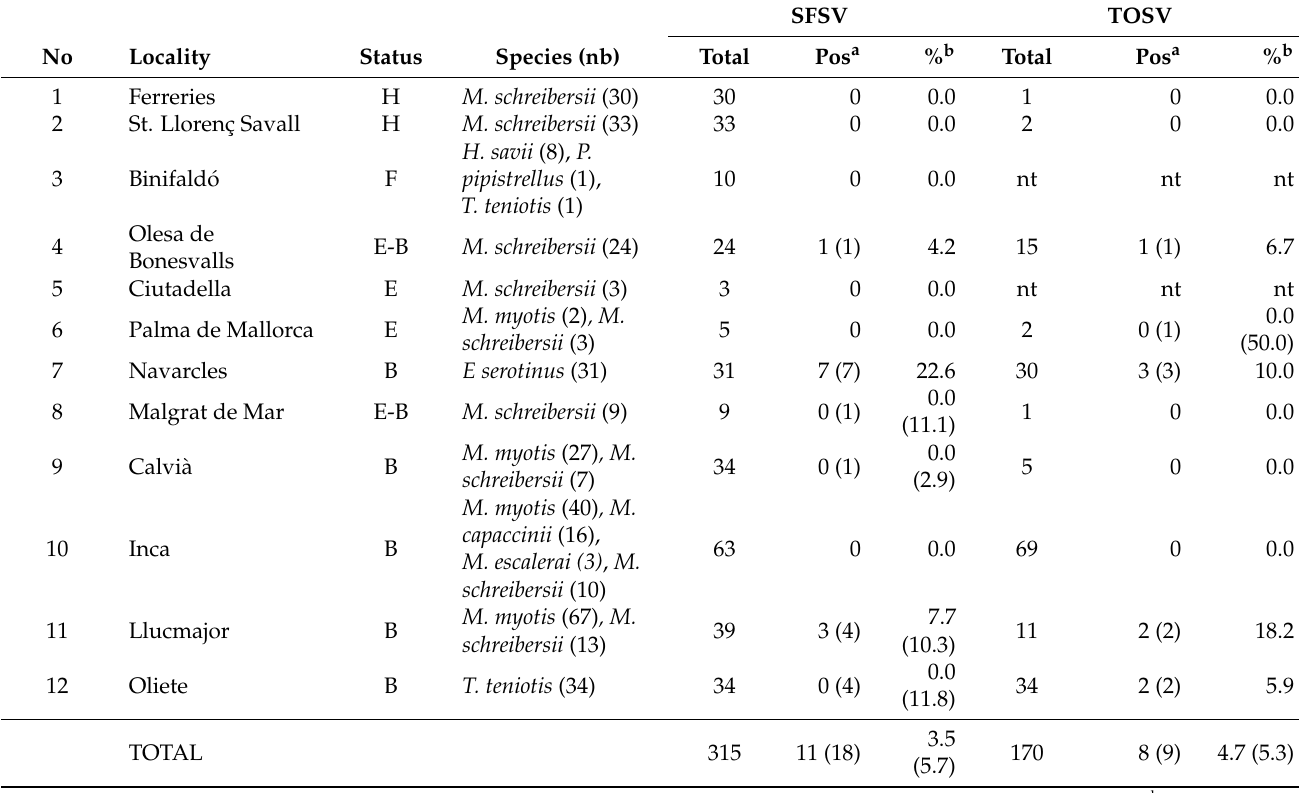
Table 2. Distribution of tested specimens per locality and presence of neutralizing antibodies against SFSV and TOSV.